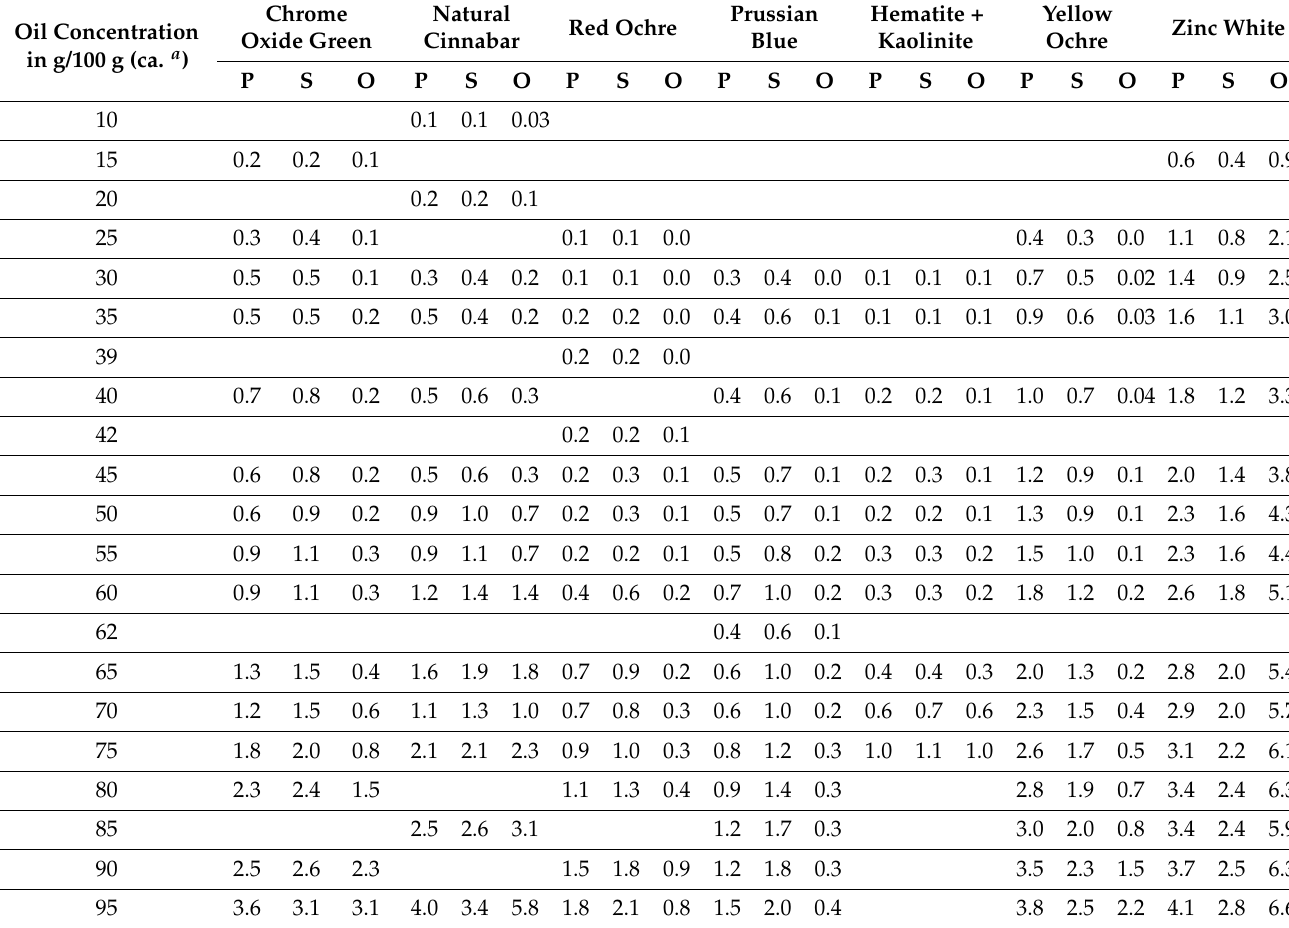
Table 3. Absolute quantification of palmitic (P), stearic (S), and oleic (O) acid in g per 100 g of dried oil paint mock-ups. The name of the pigment represents the studied pigment and linseed oil mixture. Oil Concentration in g/100 g (ca. a